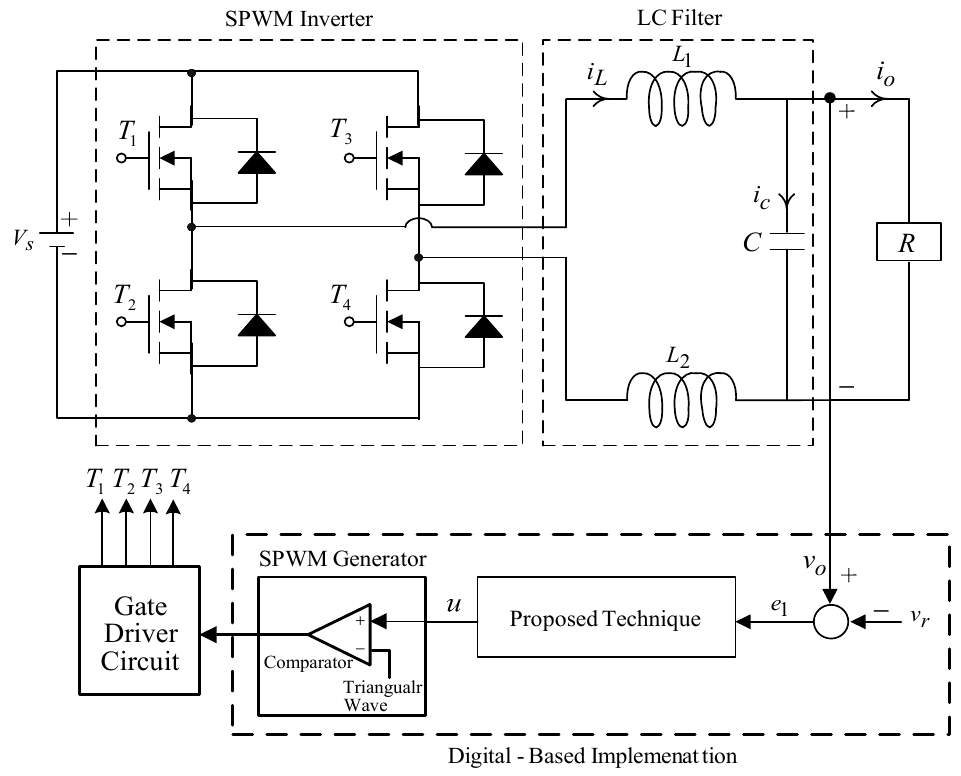
Figure 1. Block diagram of a single-phase SPWM inverter.